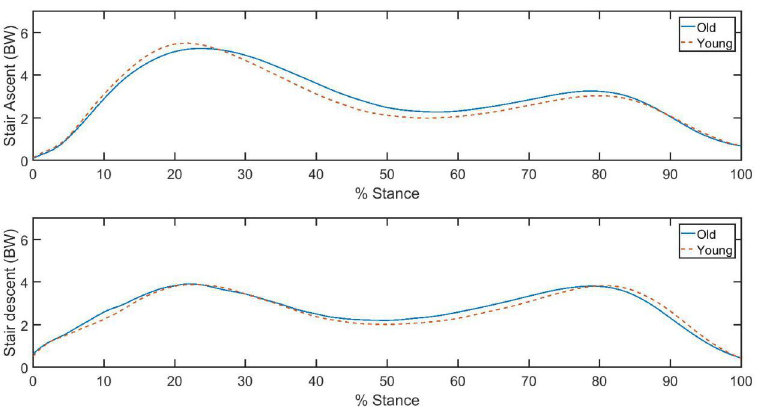
Fig 3. Ensemble average of hip joint resultant contact forces during stair ascent and descent. BW indicates body weight.